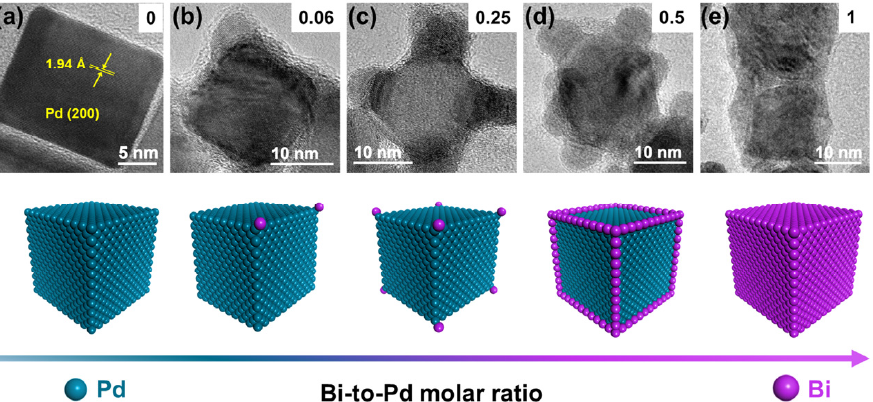
Figure 1. Selective deposition of Bi on Pd nanocubes (Pd NCs@Bi). HRTEM images of ( a ) Pd NCs, ( b ) Pd NCs@Bi 0.06 , ( c ) Pd NCs@Bi 0.25 , ( d ) Pd NCs@Bi 0.5 , ( e ) Pd NCs@Bi 1 . The illustrations in the upper right corners represent the Bi-to-Pd molar ratio. The diagram below represents corresponding models of Pd NCs@Bi.